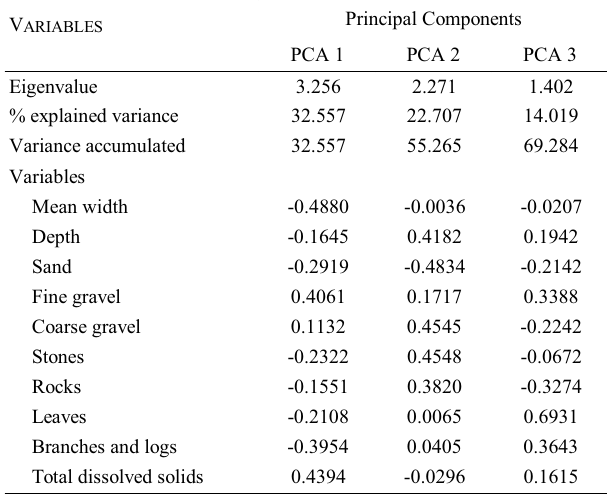
Table 2 . Eigenvalues and percent explained variance of the first three principal component axes associated with habitat parameters.